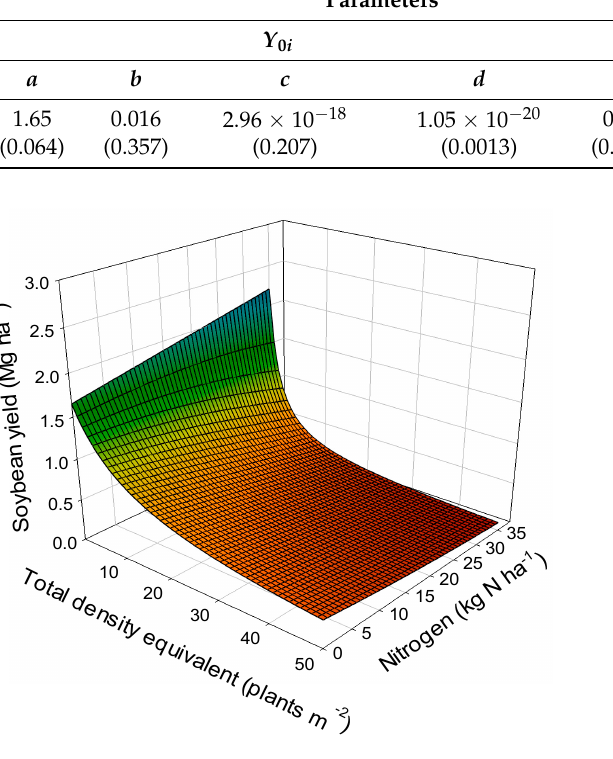
Figure 3. Soybean yield as a function of the total density equivalent and applied nitrogen in the pooled two-year data. The mesh is fitted values calculated using the combined model and parameter estimates (Table 4).